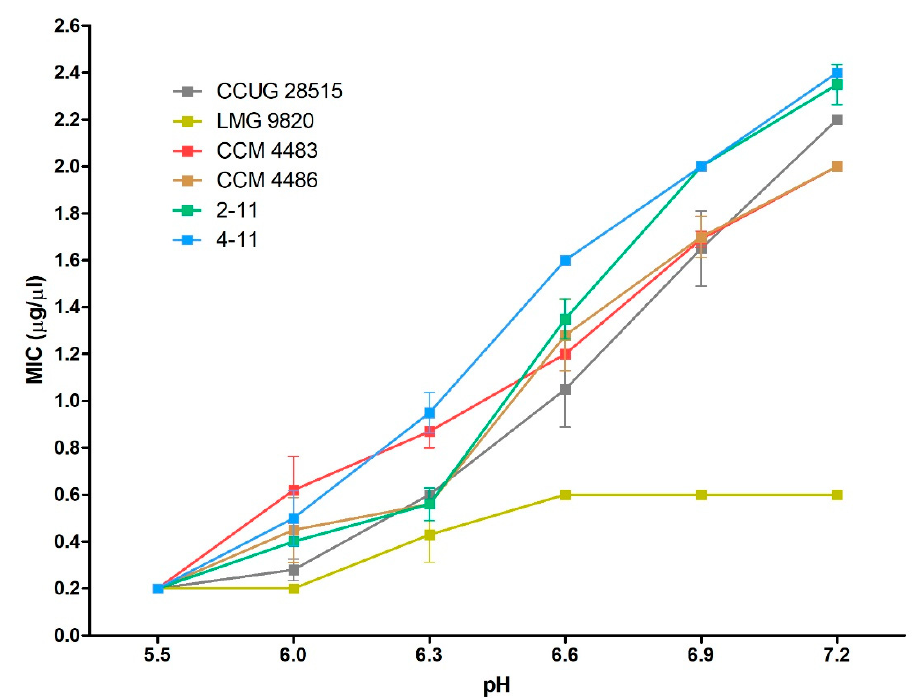
Figure 2. Effect of pH on the antibacterial efficacy of 10-HDA in selected P. larvae strains. Minimum inhibitory concentration (MIC) values are graphically depicted to compare pH-dependent susceptibility profiles of individual strains to 10-HDA. Most strains of the ERIC I and ERIC II genotypes showed similar profiles of pH-dependent susceptibility to 10-HDA. Data are expressed as mean values with standard deviations.